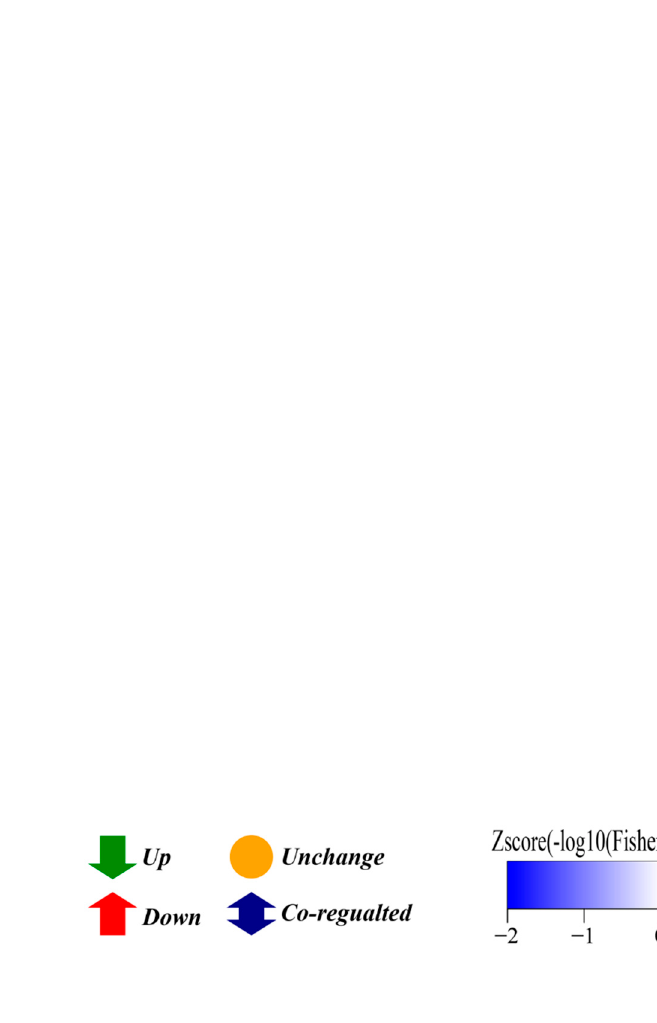
Figure 8. Enrichment correlation analyses of KEGG pathway in various comparative groups. Note: ( A ) KEGG pathway between transcription and proteomics in the D vs. S group; ( B ) KEGG pathway in the S vs. C group ( C ) KEGG pathway in the D vs. C group. There were simultaneous changes in both protein and transcription levels. KEGG, Kyoto encyclopaedia of genes and genomes.